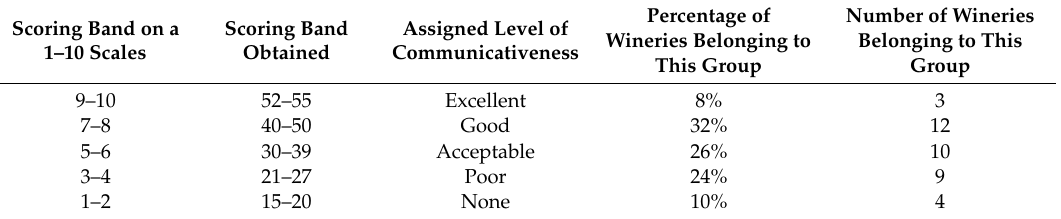
Table 4. Evaluation of websites of wineries in Mount Etna made by focus group 1.